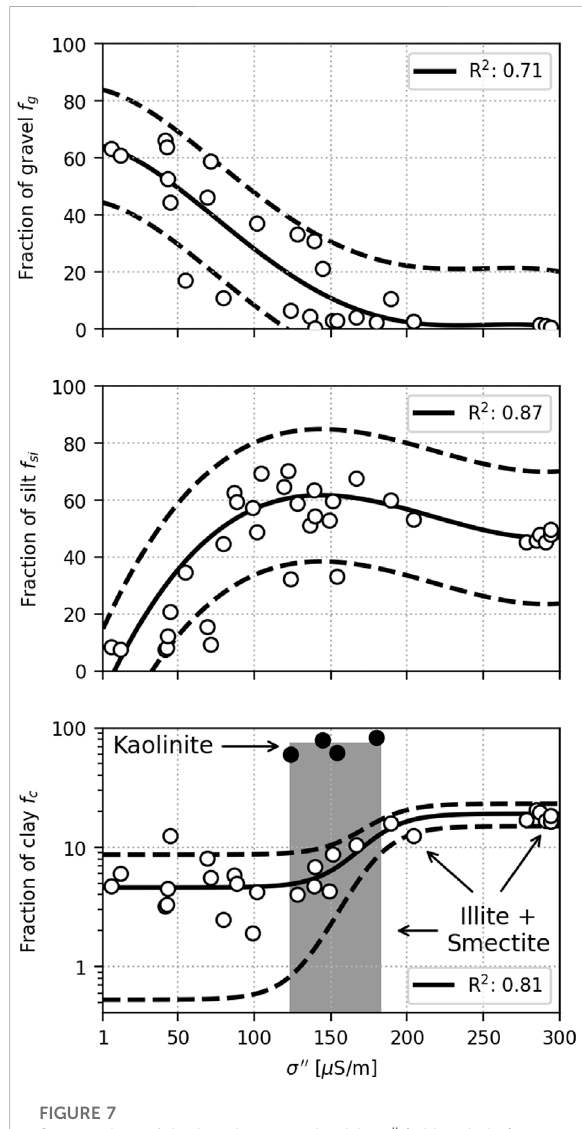
FIGURE 7 Scatter plots of the imaginary conductivity σ ″ (white circles) and volume fraction of gravel (top) and silt (center) and clay (bottom) reveal well-determined relationships, with the adjusted regression functions (black line) reaching R 2 scores > 0.7. The black dashed line indicates the con fi dence bounds computed for two times the standard deviation of the corresponding regression